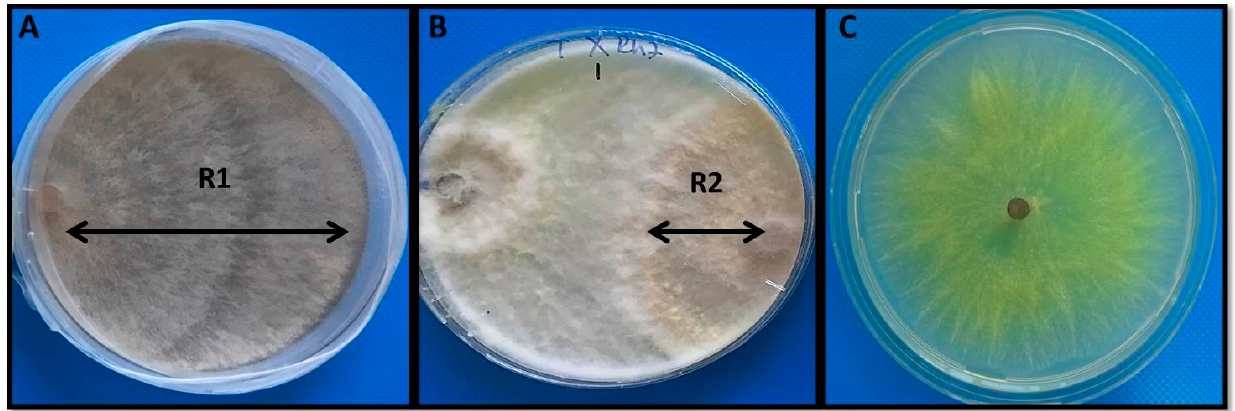
Figure 1. ( A ) Control plate with R. solani ( B ) Effect of T. citrinoviride suppressing R. solani growth ( C ) Growth of T. citrinoviride under 40 mM NaCl stress.